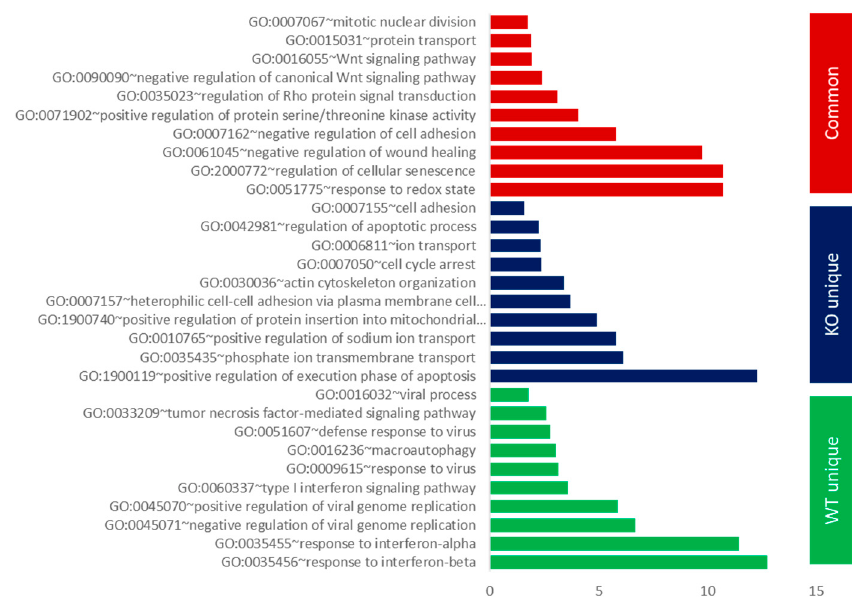
Figure 2. Gene ontology (GO) analysis of uniquely expressed genes/transcripts in A549 (WT) and A549- Δ ANXA1 (KO) infected versus control samples and commonly expressed transcripts. Top 10 of the most highly enriched items in the categories of Biological process (BP) are presented in three groups, respectively ( p < 0.01). Logarithm (base 2) of the odds ratio of the enrichment of the GO items. The larger this number is, the stronger the enrichment of the GO items among transcripts in the dataset.